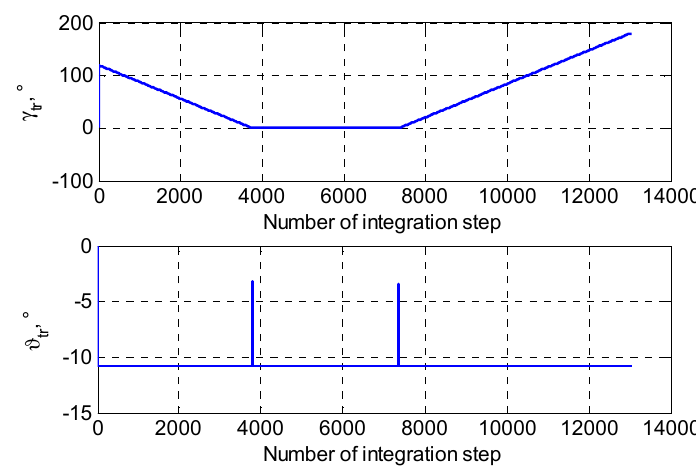
γ tr and dip angle